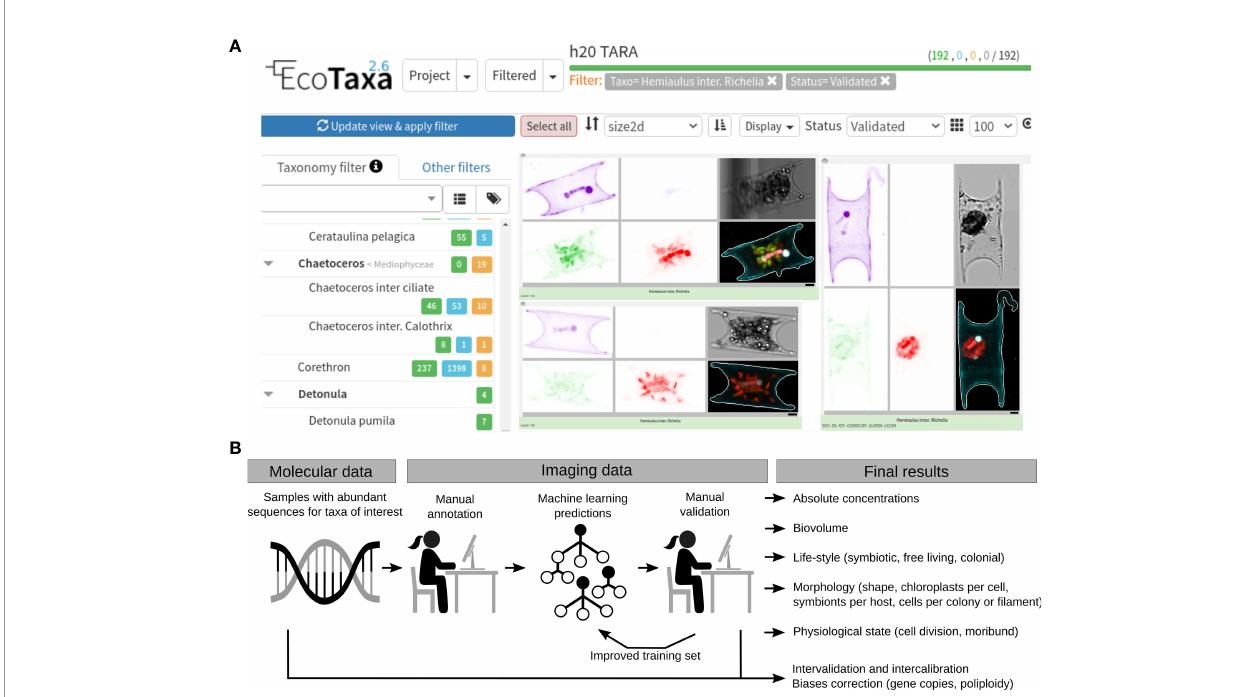
FIGURE 2 | Integration of molecular and imaging datasets with the help of EcoTaxa. (A) User interface of EcoTaxa (https://ecotaxa.obs-vlfr.fr/). The user can navigate the database along a taxonomic tree (left panel of the website) or fi lter the images according to sampling criteria (location, time, depth) or morphological features (size, chlorophyll a content, etc). The concentration and biovolume for a taxon at a given geographical location and time point can be retrieved. For operators, easy-to-use tools are provided for the rapid identi fi cation of large numbers of images by a combination of machine learning and human validation. (B) Work fl ow for the integration of molecular and imaging data. This example is based on our recent analyses of free-living and symbiotic planktonic nitrogen- fi xers in the Tara Oceans project (Pierella Karlusich et al., 2021). The molecular data was fi rst used for helping to target the manual annotation workload of the imaging data. The strategy started with the mining of molecular data (metagenomes) to select a few samples where sequences from nitrogen- fi xers were abundant, and therefore it was feasible to manually search the images from those samples through EcoTaxa. After obtaining a few manually annotated images, predictions were run for the whole dataset (all samples) and curated by visual inspection. These results were then used as a new training set for running new predictions. The imaging and molecular results were then compared to validate each other and to quantify biases (e.g., the variations in gene or genome copies per cell). Imaging-based information that cannot be determined by molecular data were also generated: absolute quanti fi cations, biovolume, symbiont number per host cell, asymbiotic partners, chloroplast content, cell number per colony/ fi